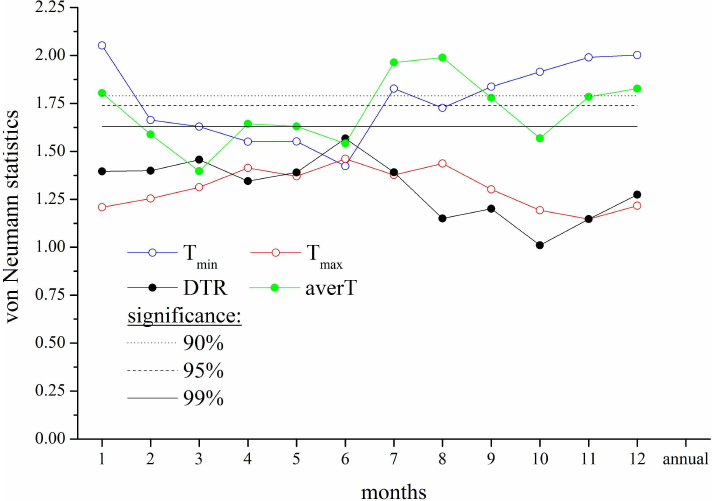
Figure 20. Coimbra: von Neumann ratio statistics for monthly series of T min , T max , DTR and T aver . Black straight lines show probability levels.